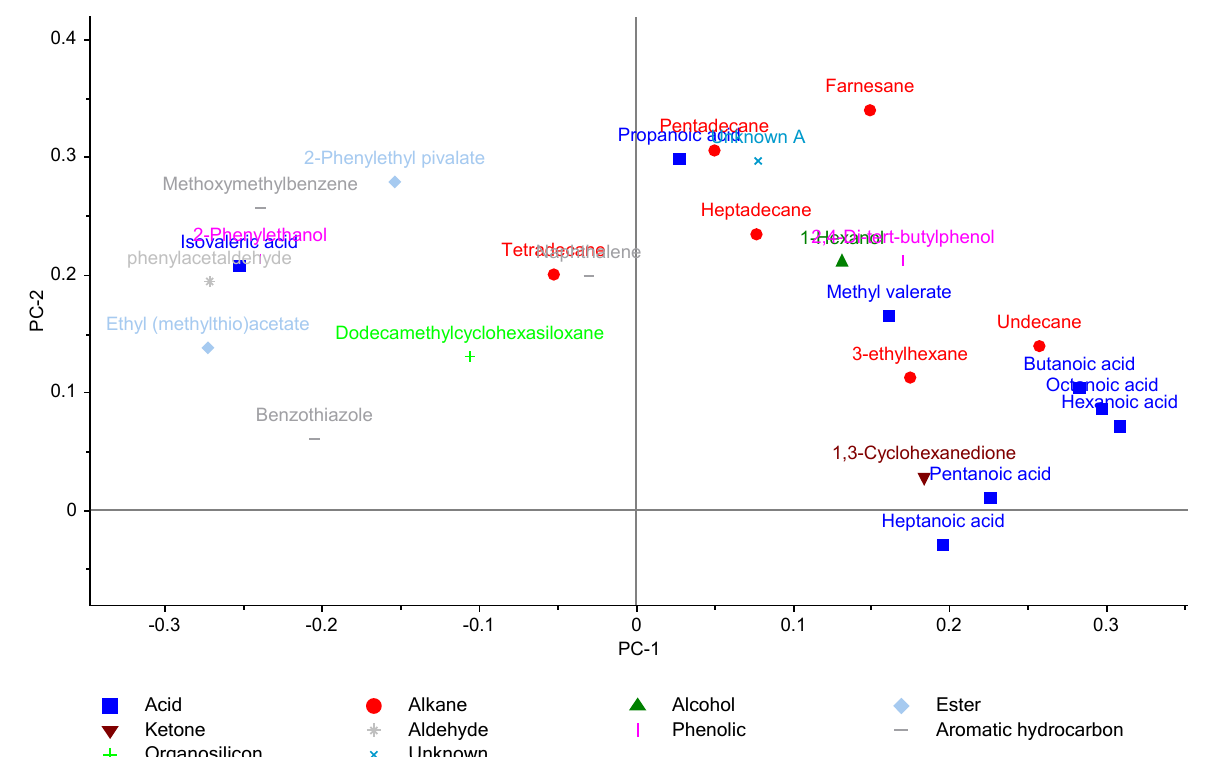
the VOC profile of the associated treatments. A shorter distance indicates a stronger sim- ilarity. Figure 7. Loadings plot showing the variable weight for each compound for PC-1 and PC-2.